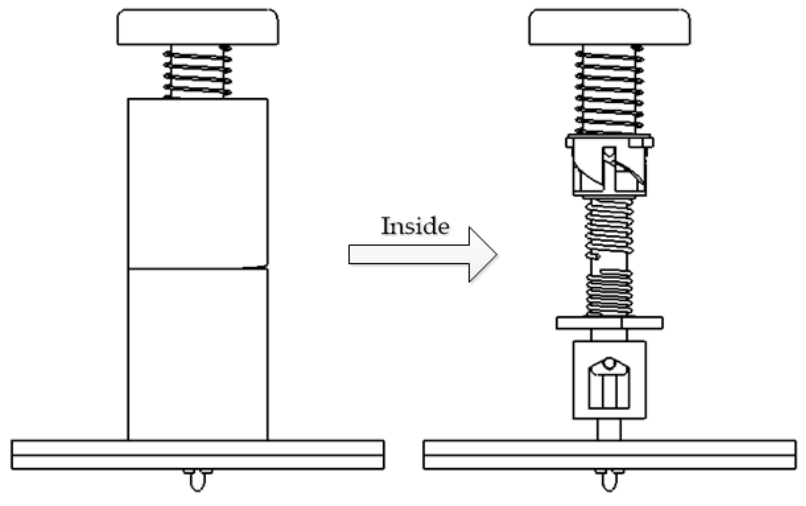
Figure 14. Clamping state of temporary fasteners.